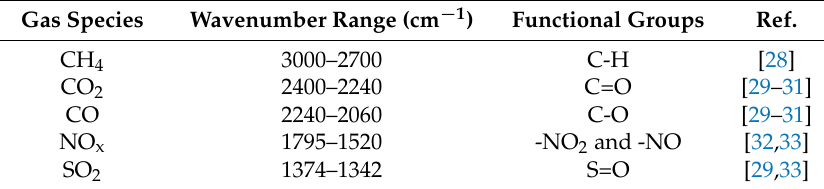
Table 1. Wavenumber intervals of different gaseous